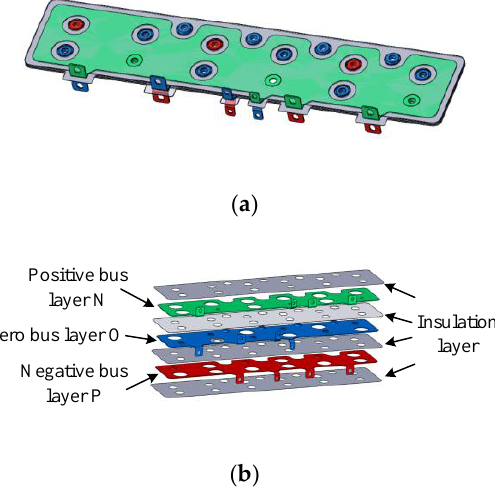
Figure 14. The relationship between the distances d 1 and d 2 and the equivalent stray inductance. With the parameters d 1 and d 2 determined, the three-dimensional diagram and layered schematic diagram of the adopted laminated busbar used are shown in Figure 15. Its features include: considering the relationship between the length of the power module and the diameter of the capacitor, three groups of capacitors are selected in parallel to reduce the miscellaneous dispersion inductance; the upper bus capacitor and the lower bus capacitor are arranged at intervals to make the enclosed area of each commutation circuit relatively balanced; the power modules on both sides of the back-to-back converter are placed separately to reduce the overlap area of the current circuits on both sides and reduce mutual inductance between the flow loops on both sides; the two connection points of each power module adopt a corner connection method to minimize the distance in the horizontal direction.